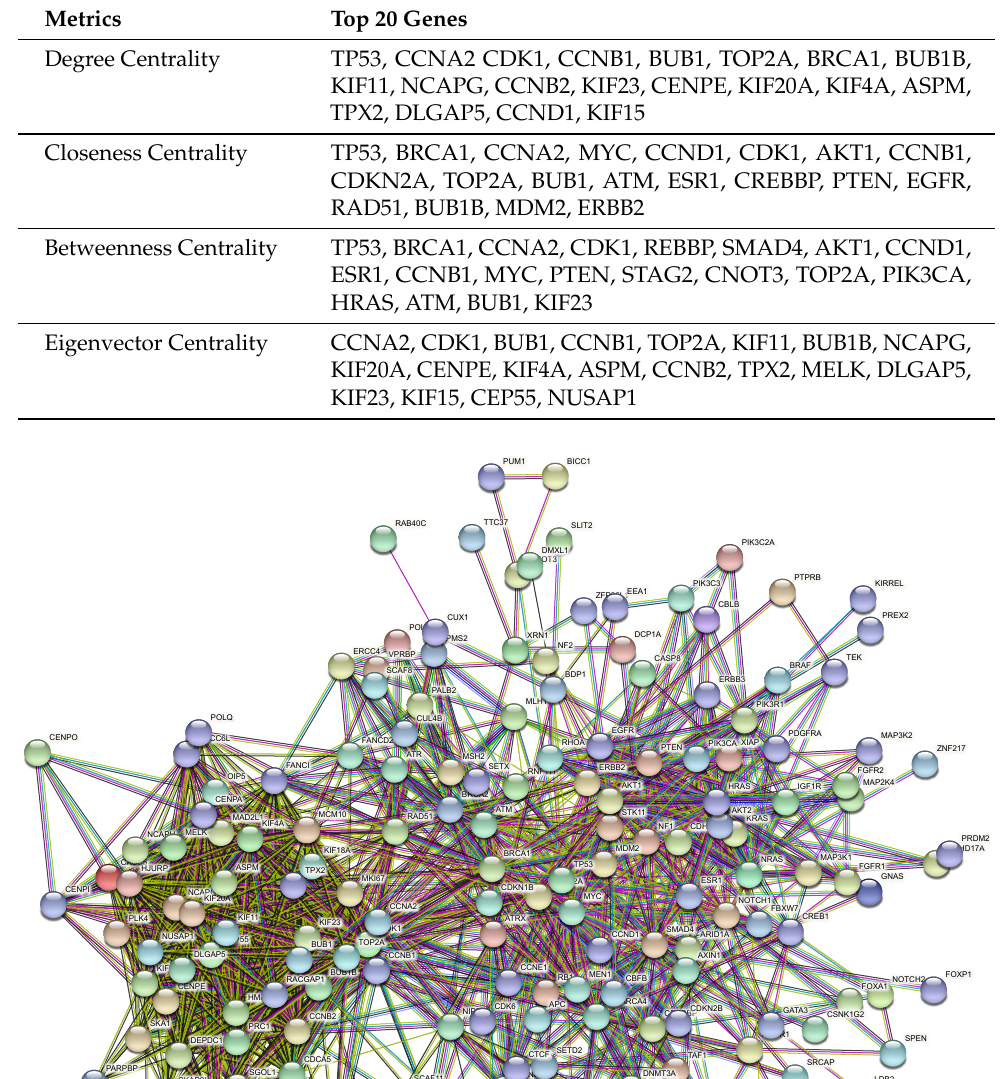
Table 2. Top 20 genes in four metrics of node centrality.